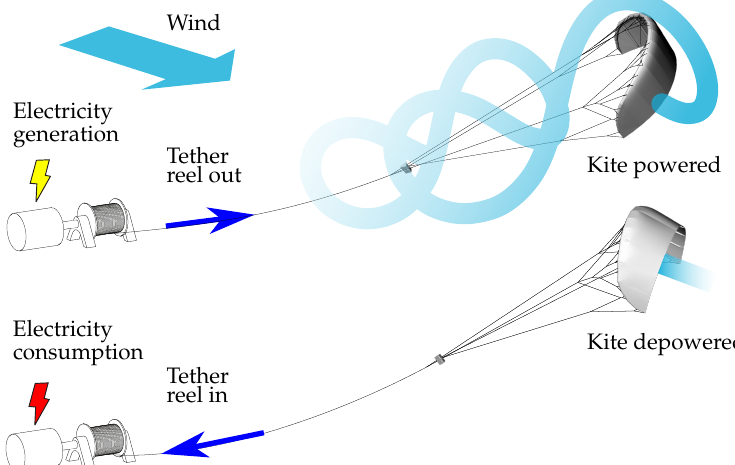
Figure 1. Working principle of the pumping kite power system of Delft University of Technology [5].